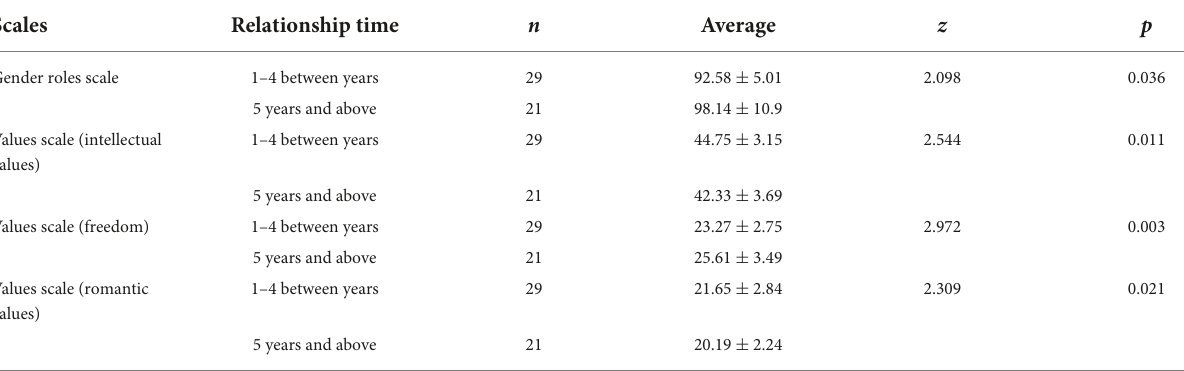
TABLE 4 Relationship between relationship duration and